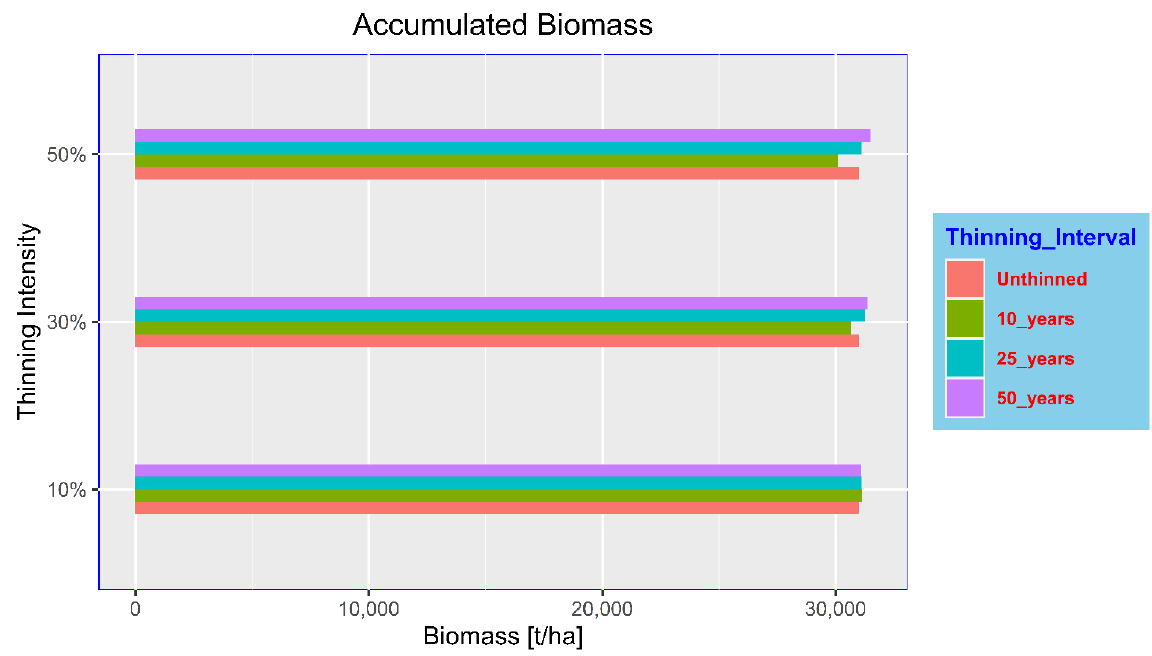
Figure 8. Accumulated biomass over the management period.